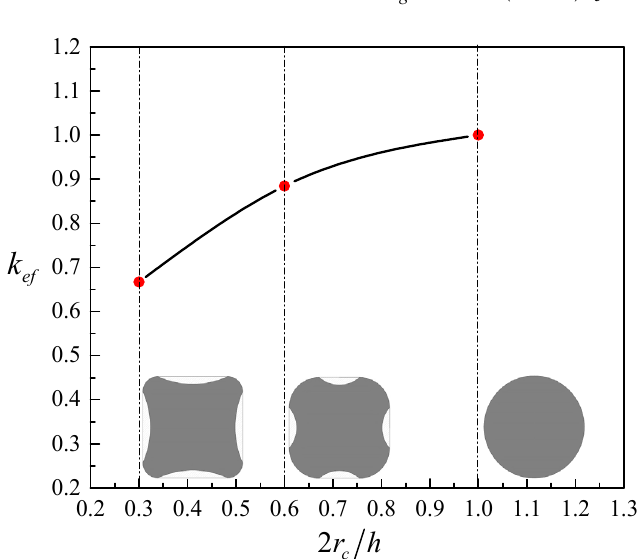
Figure 2. k ef versus 2 r c / h : considering the effect of increasing the corner radius at a constant section width.